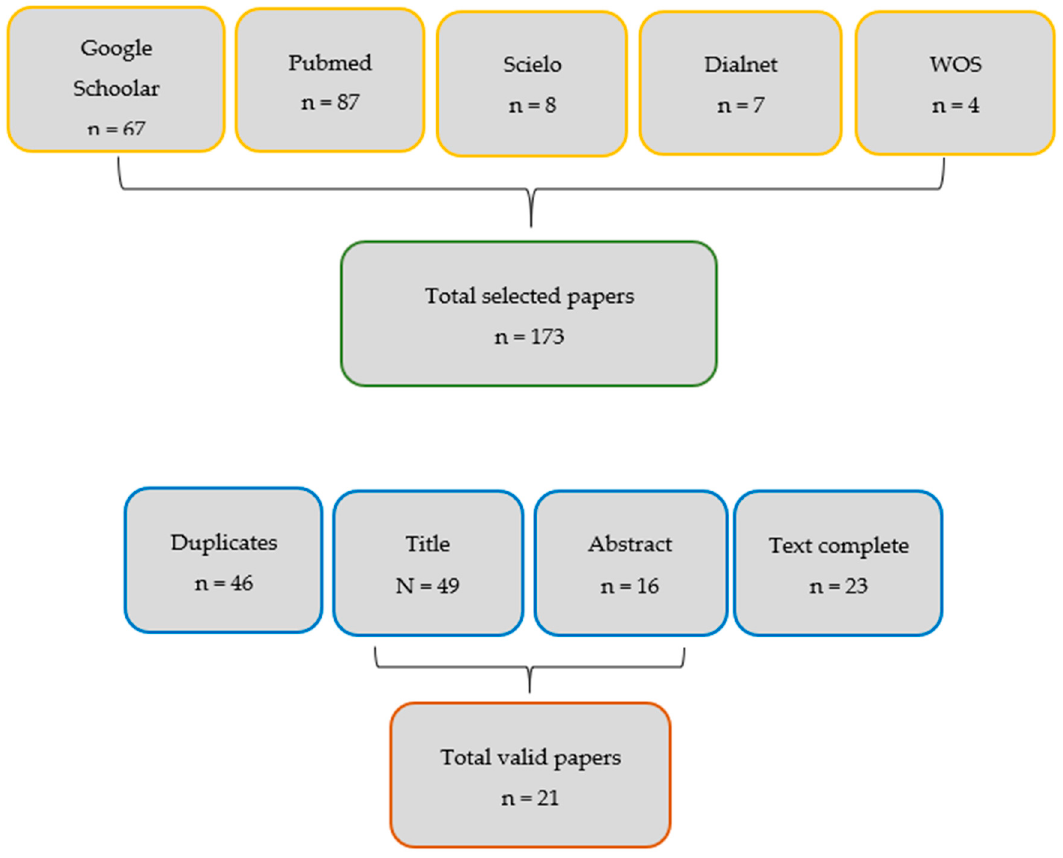
Figure 1. Flow diagram.